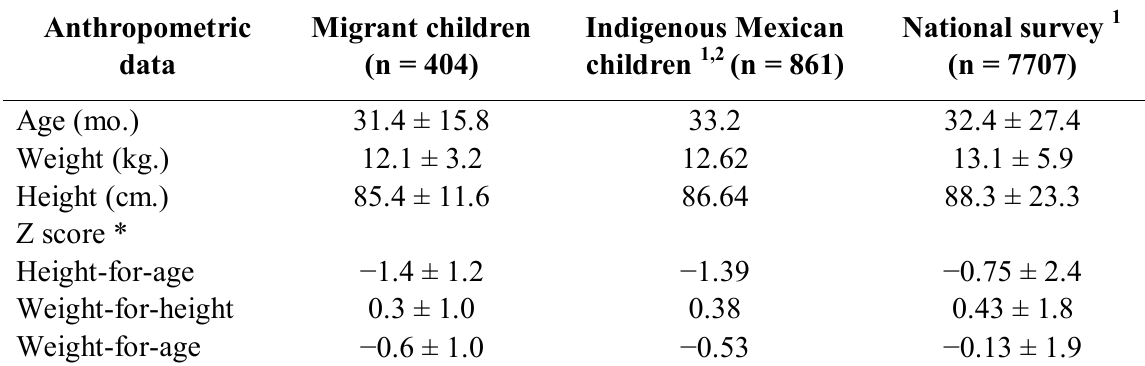
Table 1. Anthropometric data from children aged less than 5 years in three Mexicans